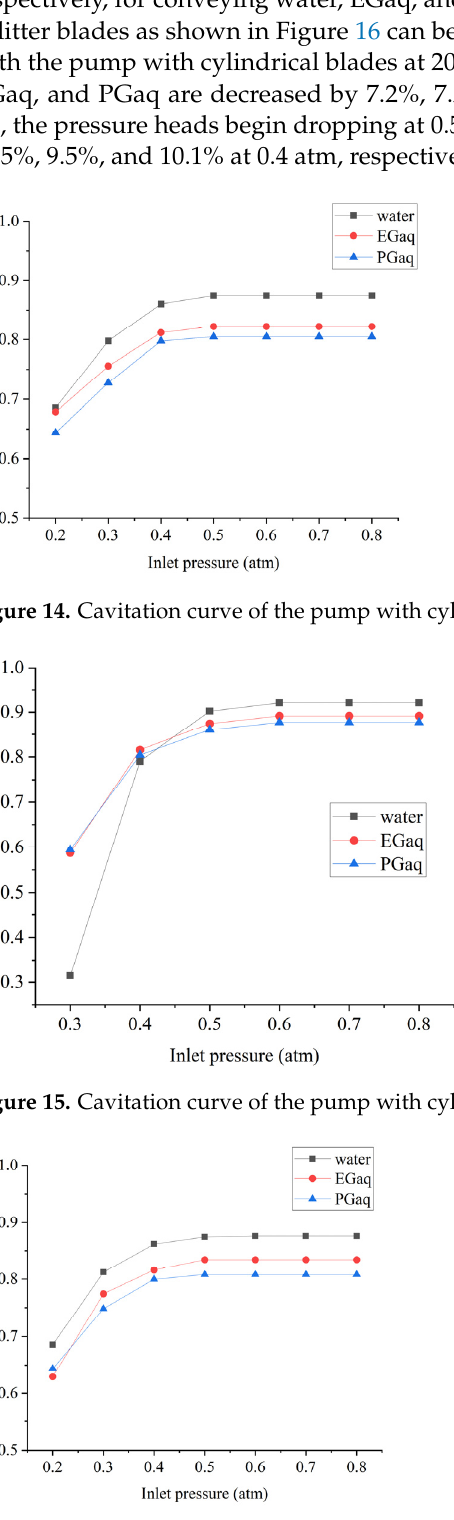
Figure 17. Cavitation curve of the pump with splitter blades at 60 °C. It is found that the inception of cavitation occurs almost at the same inlet pressure between two types of impeller blades. The drops of pressure head in the pump with split- ter blades are slightly smaller than those in the pump with cylindrical blades, indicating that the former impeller can improve the cavitation performance of the pump. The higher the working temperature is, the larger the critical inlet pressure for occurring cavitation in the pump is. At 60 °C, cavitation occurs at the pump inlet pressure below 0.6 atm, which can be easily encountered in aeronautic environment. Among different cooling media, the descending rate of the pressure head in water when occurring cavitation is much faster than that of the other two organic coolants, especially for the high working temperature. Compared between the two organic coolants, the pressure head in EGaq drops more slowly than that in PGaq under all simulated conditions, which demonstrates that the cavitation performance of EGaq is better than that of PGaq. According to the above analyses, the cavitation zones in the different pump impellers are represented by depicting the iso-surface of the vapor volume fraction of 0.5 as shown in Figures 18 and 19. The cavitation zones are shown at 20 °C with the inlet pressure of 0.3 atm and 60 °C with the inlet pressure of 0.4 atm. In Figure 18, it is shown that the volumes of cavitation zones in the three coolants are very close at the low working temperature. They occur firstly at the suction side of each blade. However, the volume of the cavitation zone in water is significantly increased at the high working temperature while the increase is very limited in EGaq and PGaq. EGaq shows the smallest inflation in the cavitation volume, which agrees well with the results obtained from the analyses on the cavitation curves. The result indicates that the volume of cavitation is related not only to the